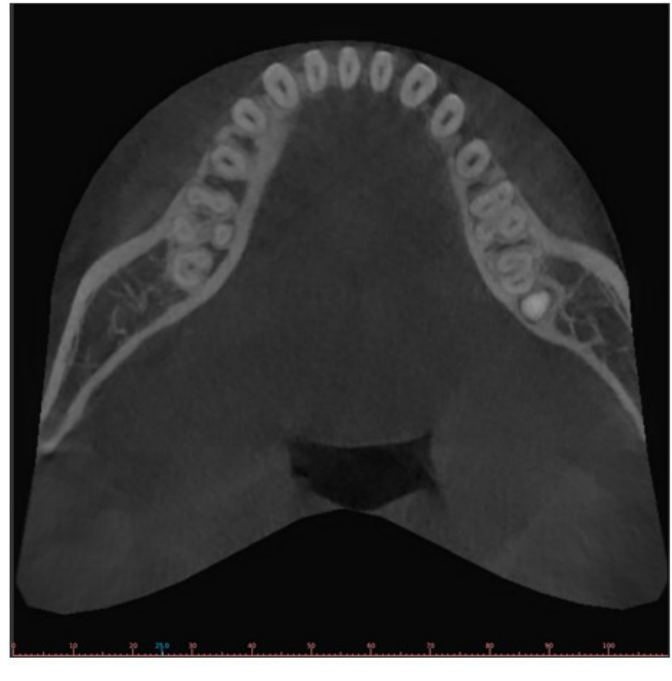
Fig. 5a - CBCT axial view - bilateral occurrence of C - shaped canals in teeth no. 37 (C3), 47 (C2) and bilateral occurrence of radices entomolaris in teeth no. 36, 46.